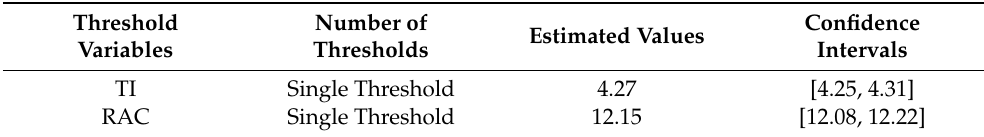
Table 12. Estimation results of threshold